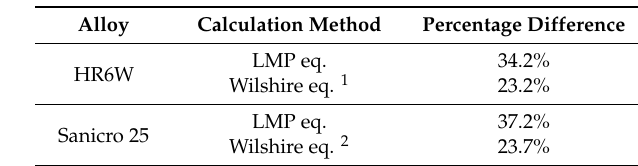
Table 9. Percentage errors of the calculated rupture times for the longest test durations for the Wilshire and LMP